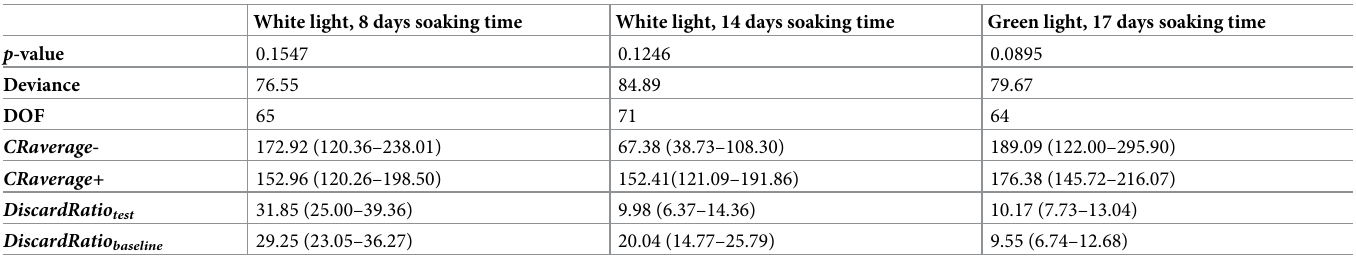
Table 2. Catch ratio ( CRw ) and fit statistics obtained for test pots using artificial lights against baseline pots without lights according to Eq (6).